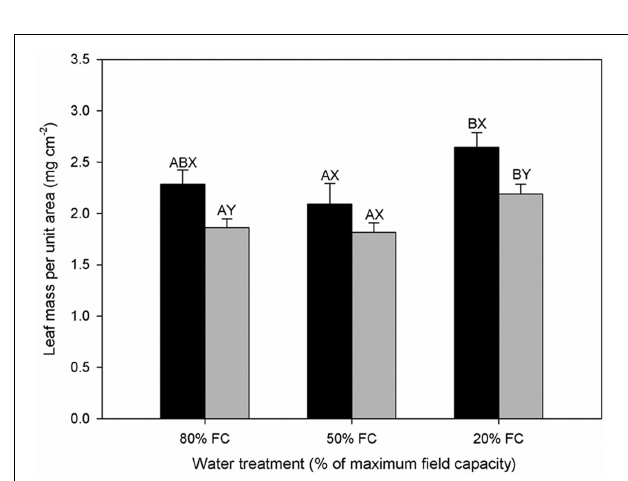
FIGURE 3 | Leaf mass per unit area (LMA) of diploids (black bars) and hexaploids (gray bars) under different soil water conditions (80% of maximal FC, 50% FC, 20% FC). Each value is presented as mean ± SE. Letters distinguish between statistically separable ( p < 0.05) values for different water treatments (A, B, C) and for different cytotypes (X,